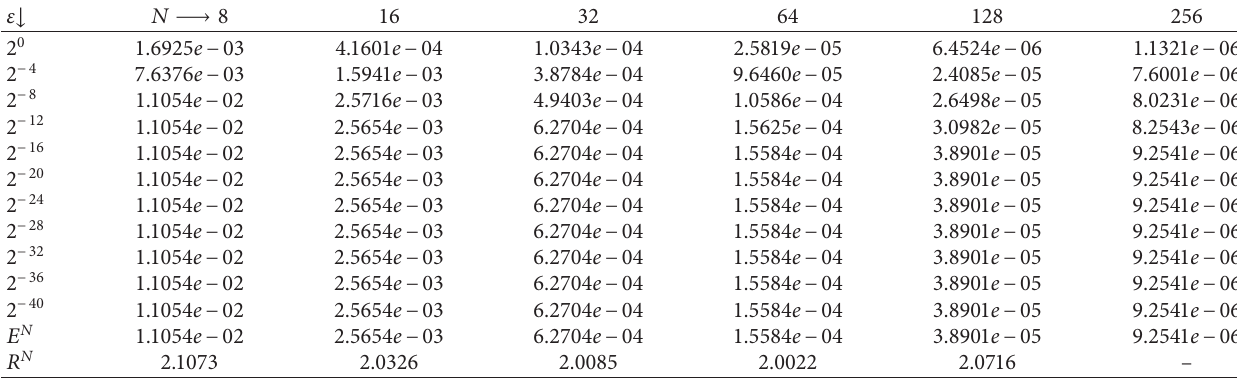
Table 4: Maximum absolute error of Example 2 after Richardson extrapolation for δ � 0 . 6 ε and η � 0 . 5 ε